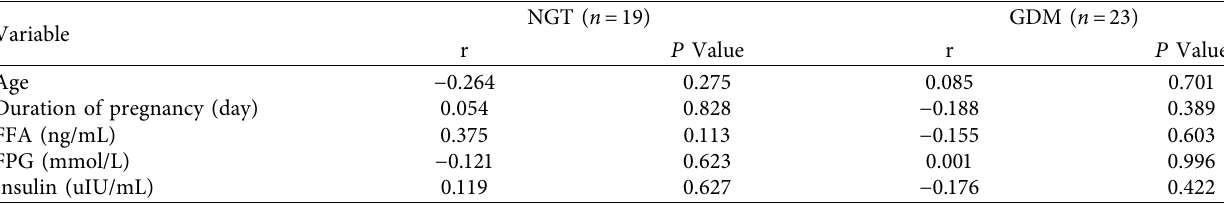
Table 2: Correlation analysis results between maternal serum ANGPTL8 and parameters of pregnant subjects with normal glucose tolerance (NGT) and with diabetes mellitus (GDM).